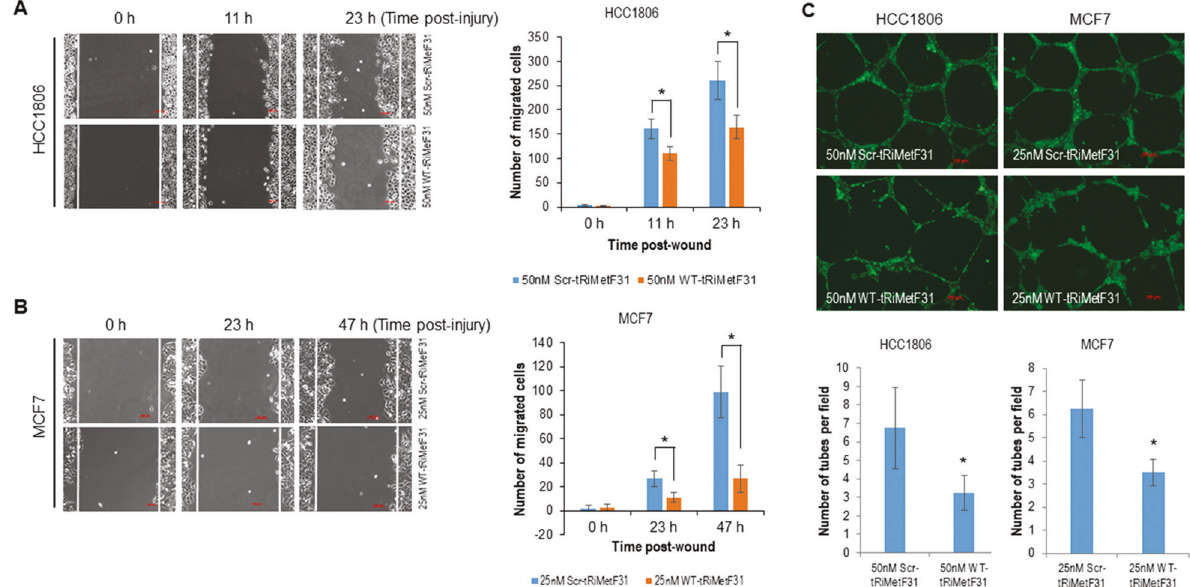
Fig. 5 Ectopic tRiMetF31 inhibited the migration and angiogenesis of breast cancer cells. A , B HCC1806 (A) and MCF7 (B) cells grown in 6-well plates were transfected with either 50 nM or 25 nM WT-tRiMetF31 or Scr-tRiMetF31_2; at 22 h after transfection, the cells were treated with mitomycin C for 2 h, and a wound-healing assay was then performed. C Tube-formation assay was carried out using 50% of 48 h conditioned medium from either HCC1806 or MCF7 cells transfected with either 50 nM or 25 nM WT-tRiMetF31 or Scr-tRiMetF31_2 as detailed in the “ Materials and methods ” . * indicates P <